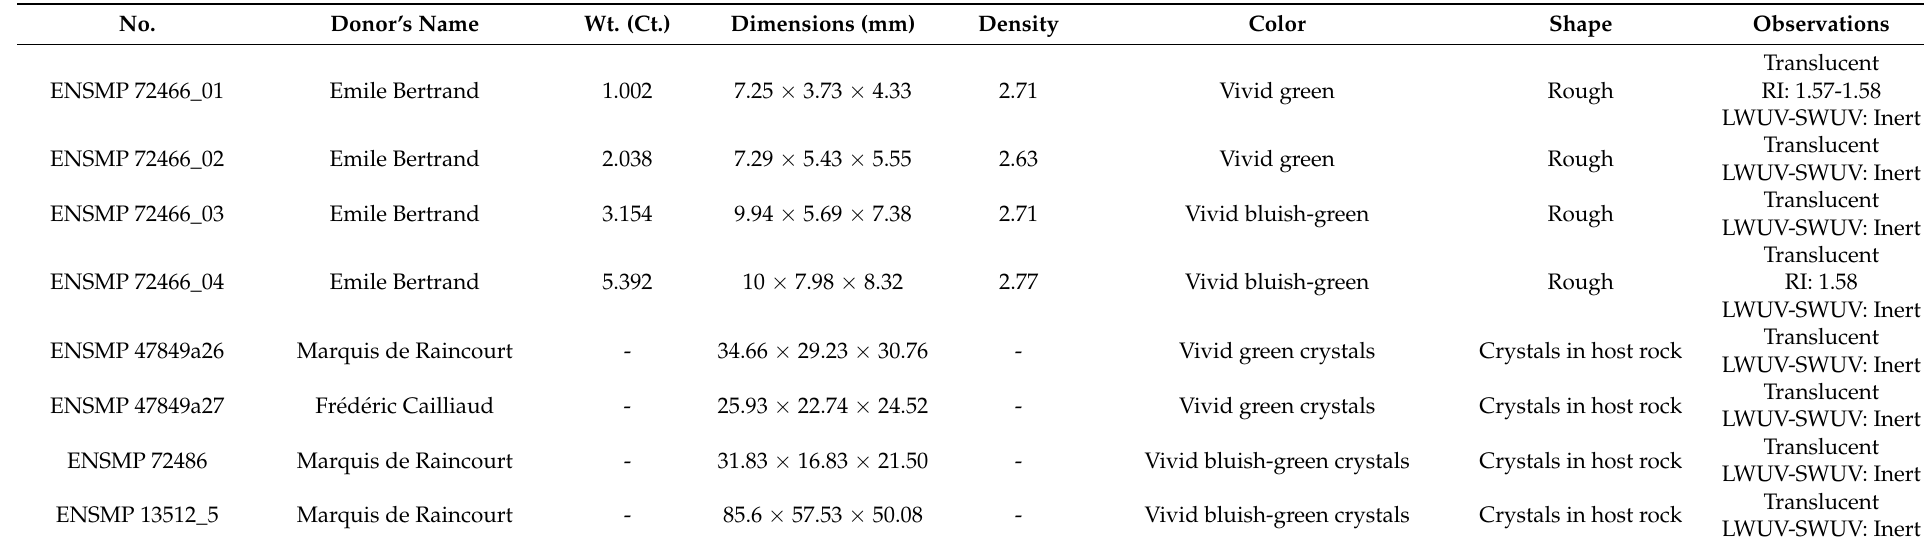
Table 1. Properties of Egyptian emeralds from Ecole des